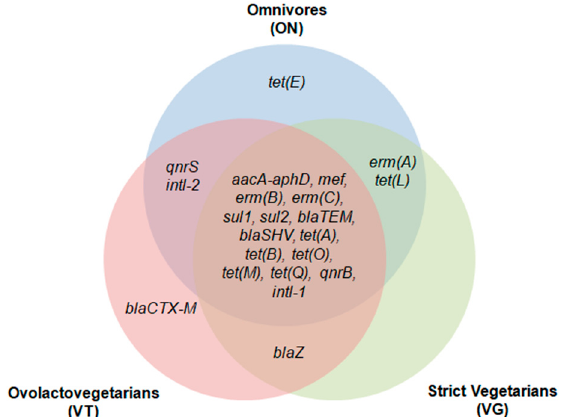
Figure 3. Venn diagram representing the occurrence of antimicrobial resistance genetic markers (ARG) and qualitative clustering according to their positive screening exclusively or shared between omnivores (ON), ovolactovegetarians (VT), and strict vegetarians (VG). β -lactams ( bla CTX-M , bla TEM , bla SHV , blaZ , mef ); tetracyclines ( tet(A) , tet(B) , tet(E) , tet(L) , tet(M) , tet(O) , tet(Q) ); macrolide lincosamide and streptogramin (MLS) group ( ermA , ermB , ermC ); quinolones ( qnrB , qnrS ); sulfonamides ( sul1 , sul2 ); aminoglycosides ( aacA-aphD ); and integrons ( intl-1 , intl-2 ).